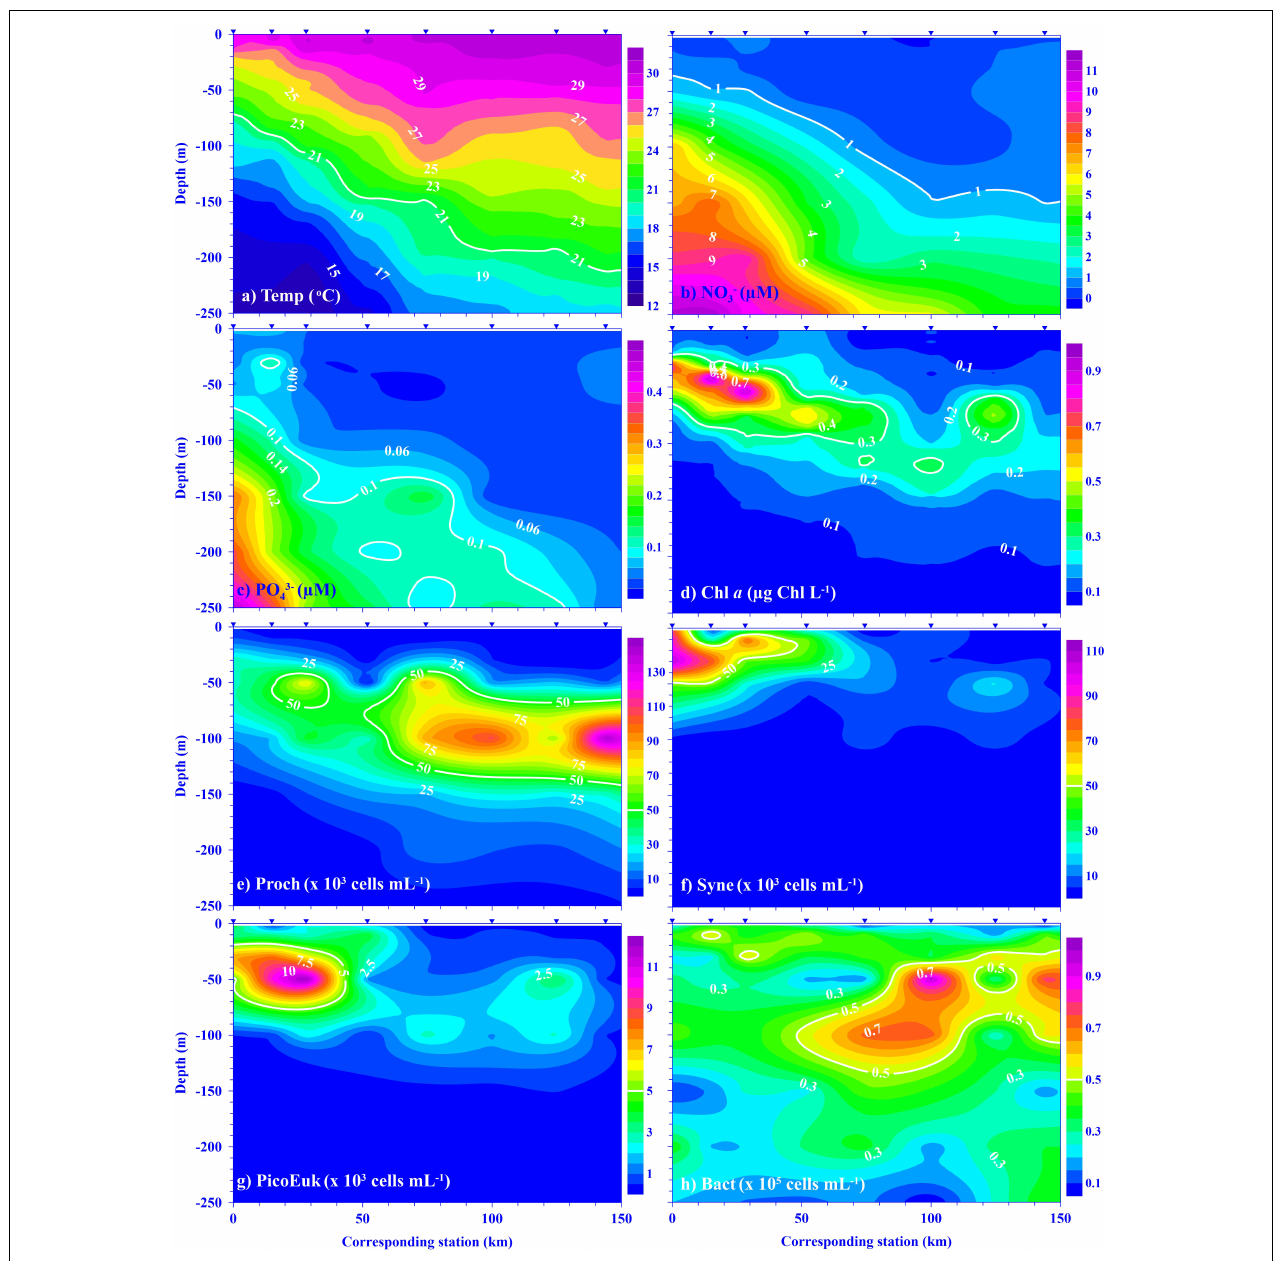
FIGURE 2 | Typical depth profile contour plots of (a) temperature (Temp; ◦ C), (b) nitrate (NO 3 − ; µ M), and (c) phosphate (PO 43 − ; µ M), (d) chlorophyll a (Chl a ; µ g Chl L − 1 ), (e) Prochlorococcus (Proch; × 10 3 cells mL − 1 ), (f) Synechococcus (Syne; × 10 3 cells mL − 1 ), (g) picoeukaryotes (PicoEuk; × 10 3 cells mL − 1 ), (h) heterotrophic bacteria (Bact; × 10 3 cells mL − 1 ) within 250 m water depth along sampling stations in July 2014. Contour lines in white bold are guidelines including: temperature (21 ◦ C), nitrate (1 µ M), phosphate (0.1 µ M), Chl a (0.3 µ g Chl L − 1 ), Proch (50 × 10 3 cells mL − 1 ), Syne (50 × 10 3 cells mL − 1 ), PicoEuk (5 × 10 3 cells mL − 1 ), and Bact (0.5 × 10 5 cells mL − 1 ). The inverse triangles at the top of each panel indicate the locations of Stations K101–K108 along the KTV1 transect ( Figure 1 ).